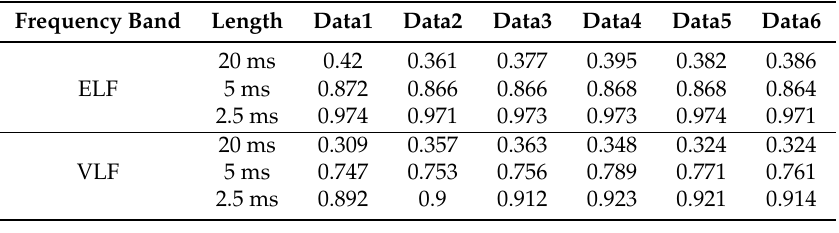
The proportion of the normal distribution of the atmospheric noise at different frequency bands. Frequency Band Length